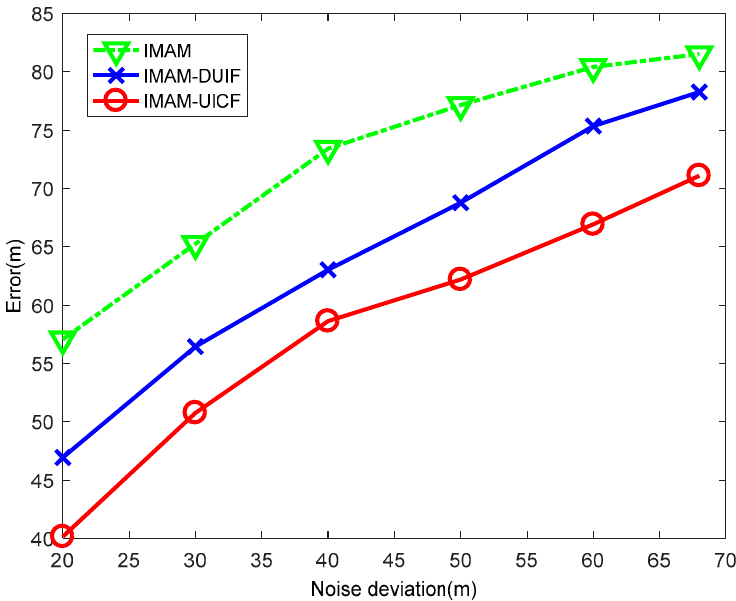
Figure 14. The velocity ARMSE of the three algorithms with varying measurement noise.